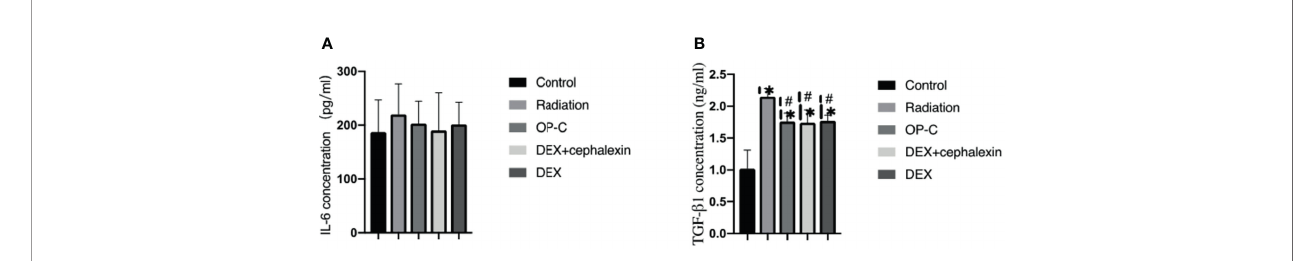
FIGURE 3 | Effects of OP-C on cytokine expression in serum. Expression of IL-6 (A) and TGF- b 1 (B) in the serum were measured in mice from the blank control, radiation only, OP-C, DEX, and DEX + cephalexin groups. The presented data are expressed as the mean ± SEM. *p < 0.05, compared with the control group. # p < 0.05, compared with the